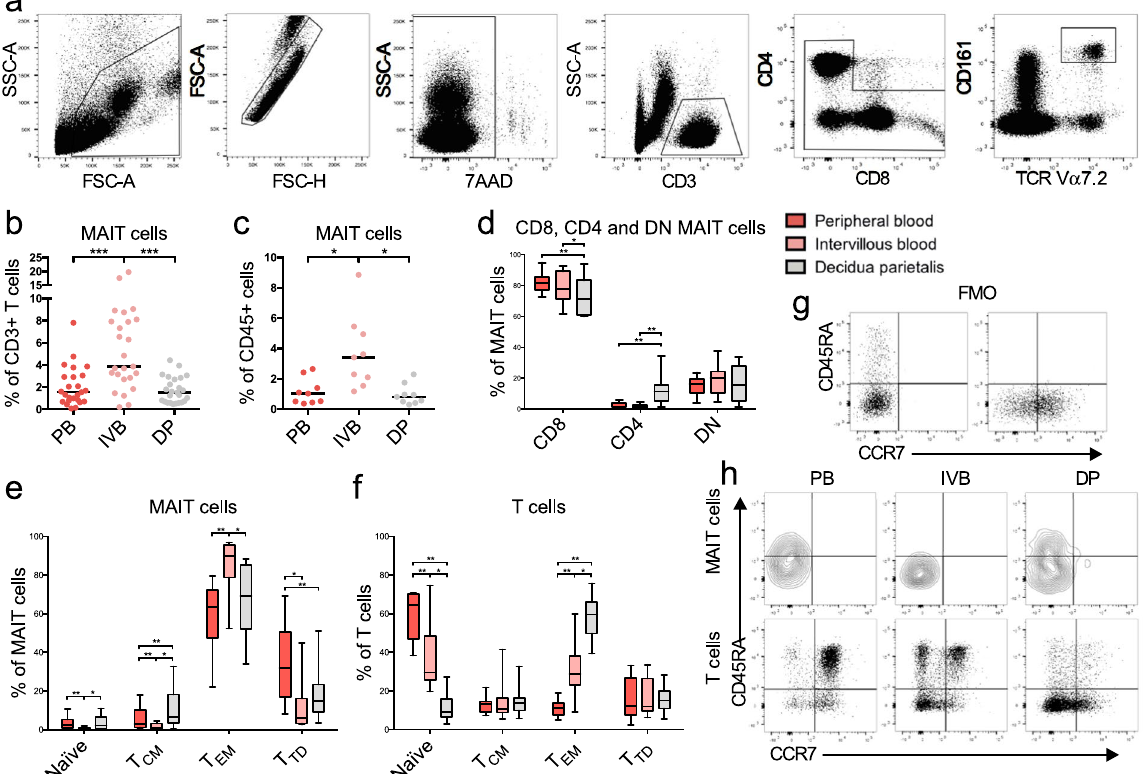
Figure 1. Increased frequency of MAIT cells in intervillous blood. ( a ) Representative flow cytometry plots showing gating strategies to identify CD161 high and V α 7.2 + MAIT cells. ( b – f ) Comparison between paired samples of peripheral blood (PB), intervillous blood (IVB), and decidua parietalis (DP) cells. MAIT cells expressed as percentage of ( b ) CD3 + , ( n = 25) and ( c ) CD45 + ( n = 9) cells. ( d ) CD4 + , CD8 + , and double negative (DN) MAIT cells expressed as percentage of total MAIT cells ( n = 11). ( e ) CD45RA + CCR7 + (Naïve), CD45RA − CCR7 + (Central memory, T CM ), CD45RA − CCR7 − (Effector memory, T EM ), and CD45RA + CCR7 − (Terminally differentiated, T TD ) MAIT cells expressed as percentage of total MAIT cells ( n = 11) and ( f ) T cells expressed as percentage of total T cells ( n = 11). ( g ) Fluorescence minus one (FMO) controls for the experiments in ( e , f ), and ( h ) representative flow cytometry plots showing gating strategies for Naïve, T CM , T EM and T TD MAIT cells (top) and T cells (bottom). Box and whisker plots show median, interquartile range and range of paired samples. The Friedman test followed by the Wilcoxon signed rank test was used to detect statistically significant differences across multiple paired samples ( b – f ). A Bonferroni corrected p value was used. * P < 0.05, ** P < 0.01, *** P <